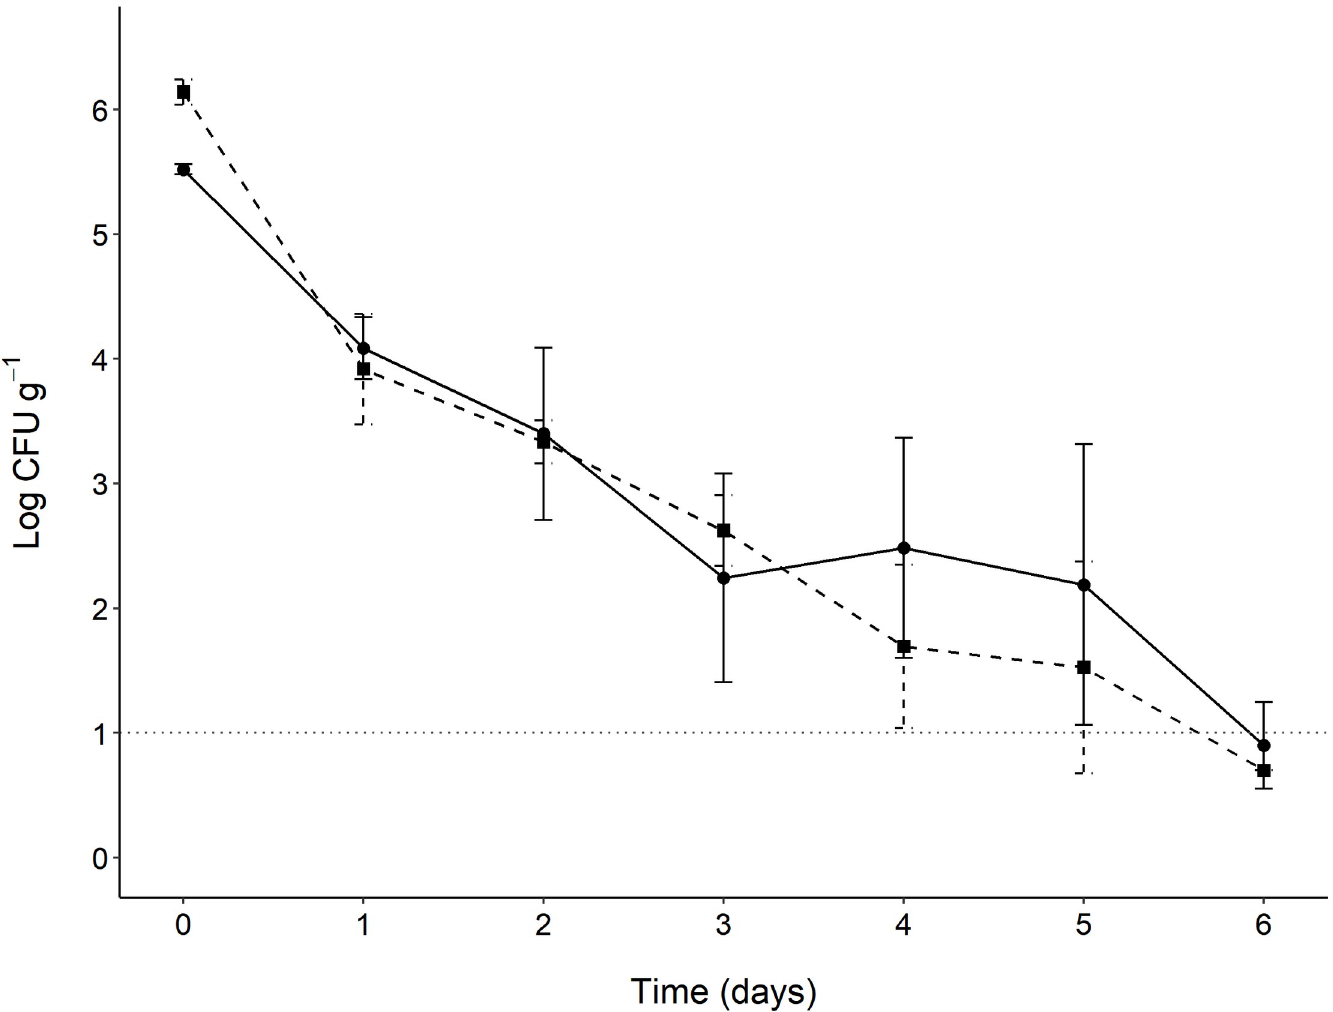
Fig 1. Survival of Salmonella Typhimurium (ST) in irradiated ( ■ ; dashed line) and natural ( ● ; solid line) poultry litter (pH 8.0, 0.92 a w , 30˚C). Limit of detection (1 log CFU g -1 ) represented by the dotted line. Data points represent means and error bars represent standard deviations (n = 3).